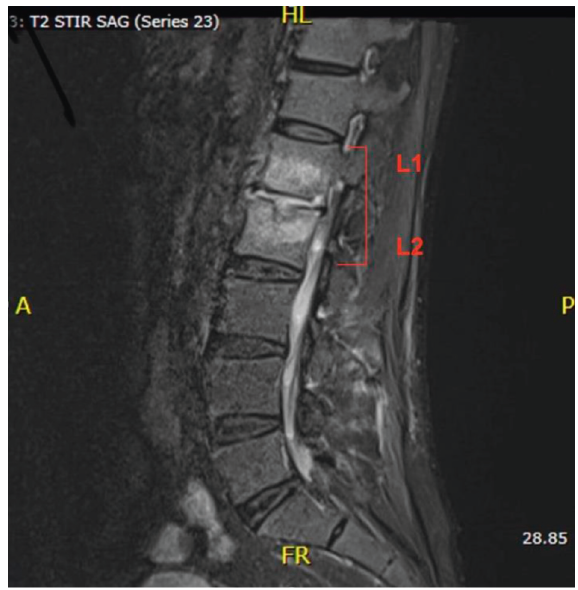
Figure 3: MRI of the spine with paraspinal soft tissue swelling and enhancement at the level of L1 and L2 as well as ventral epidural enhancement without rim-enhancing intraspinal or paraspinal fluid collections.